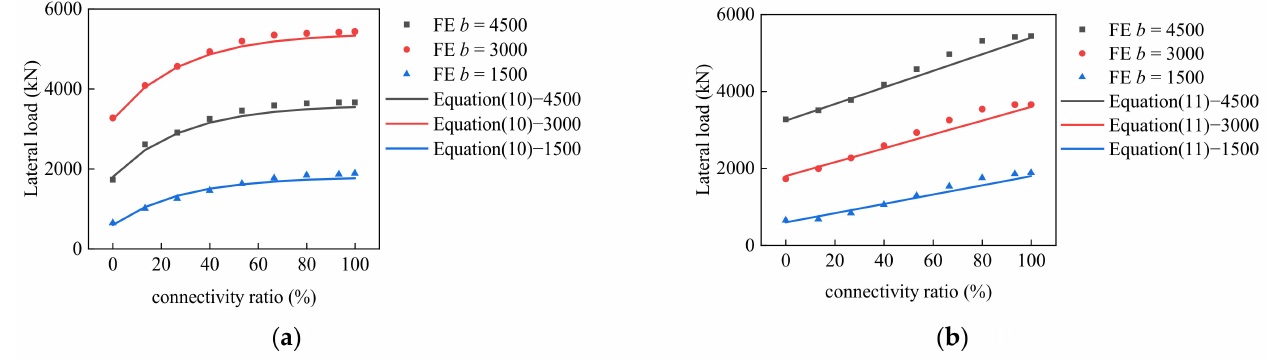
Figure 13. Comparison results of prediction equation and FE method for: ( a ) S1, and ( b ) S1R